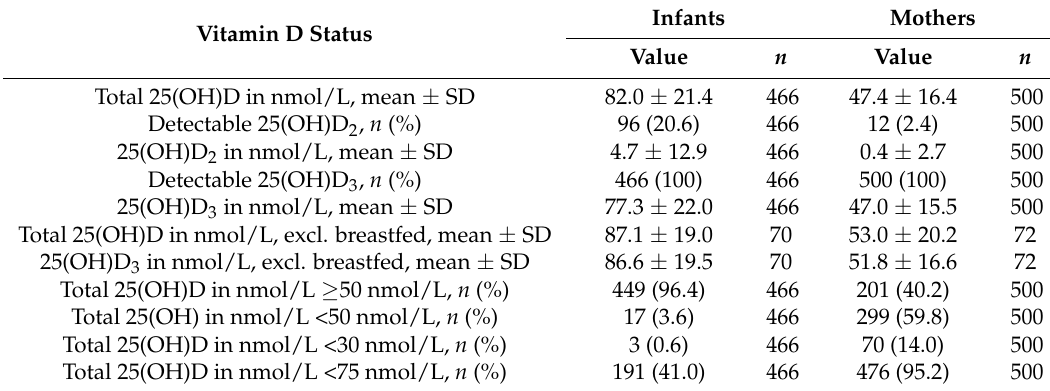
Table 3. Vitamin D status of infants and their mothers in a nutritional survey in Bhaktapur, Nepal.